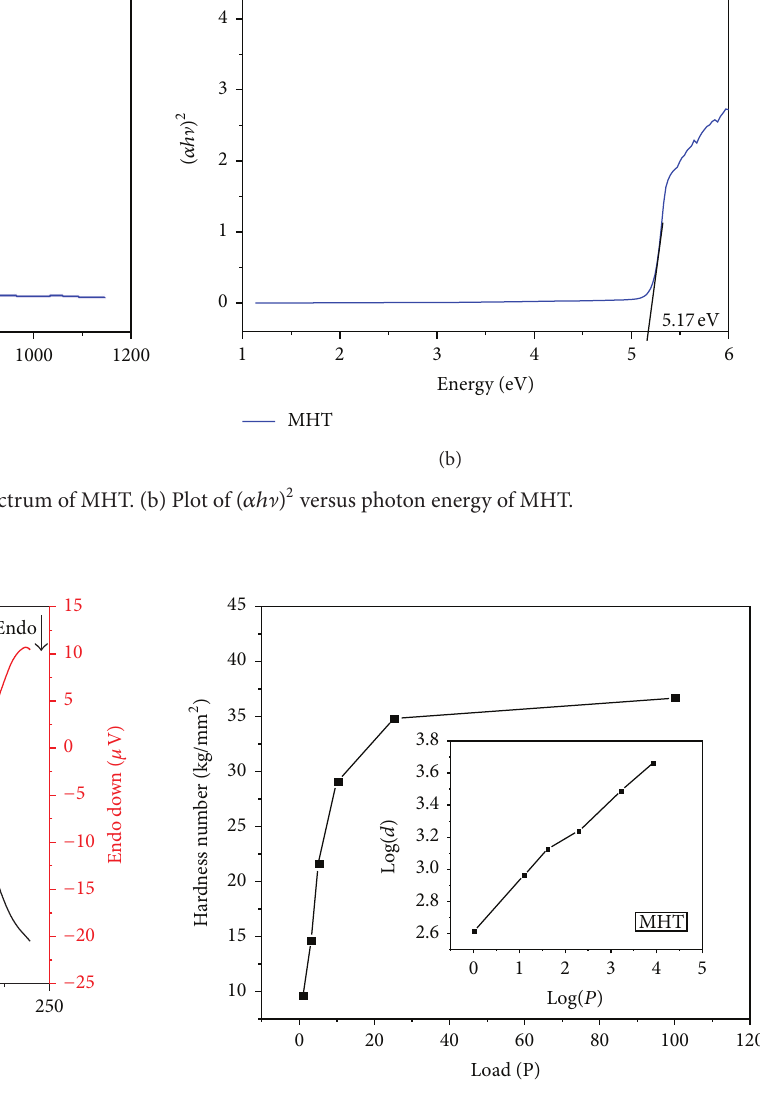
Figure6:VariationofmicrohardnessnumberwithloadandLog (𝑃) versus Log (𝑑)